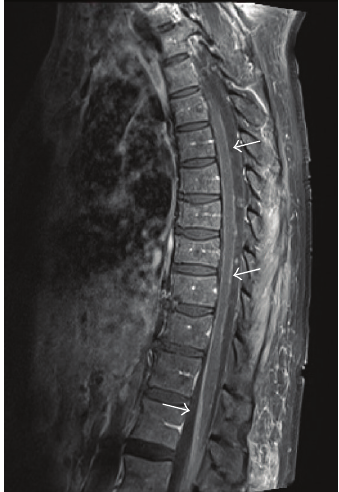
Figure 3: Sagittal T 1 postcontrast fat-suppressed image of the thoracic spine: linear leptomeningeal enhancement of the thoracic spinal cord and cauda equina nerve